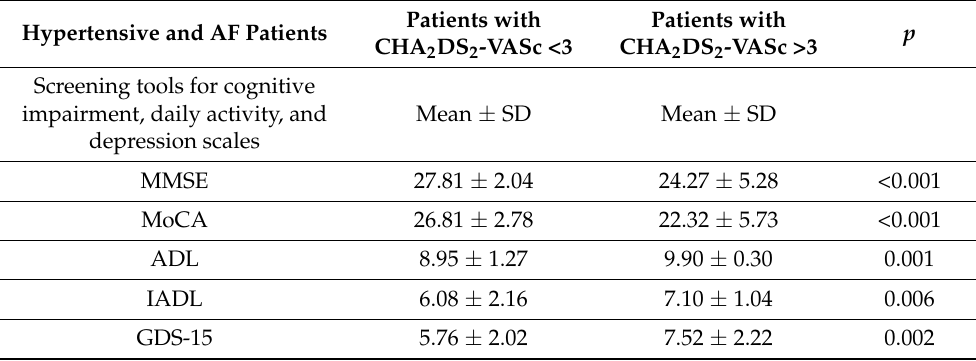
Table 6. Screening tools for cognitive impairment, daily activity, and depression scalesin hypertensive and AF patients with score CHA 2 DS 2 -VASc <3 versus CHA 2 DS 2 -VASc >3.